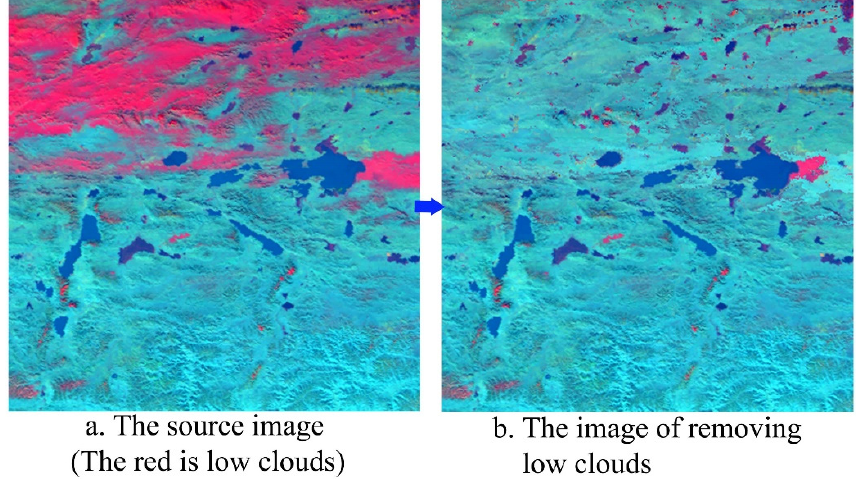
Figure 3. The low-cloud-removed image ( a ) and its source image ( b ).